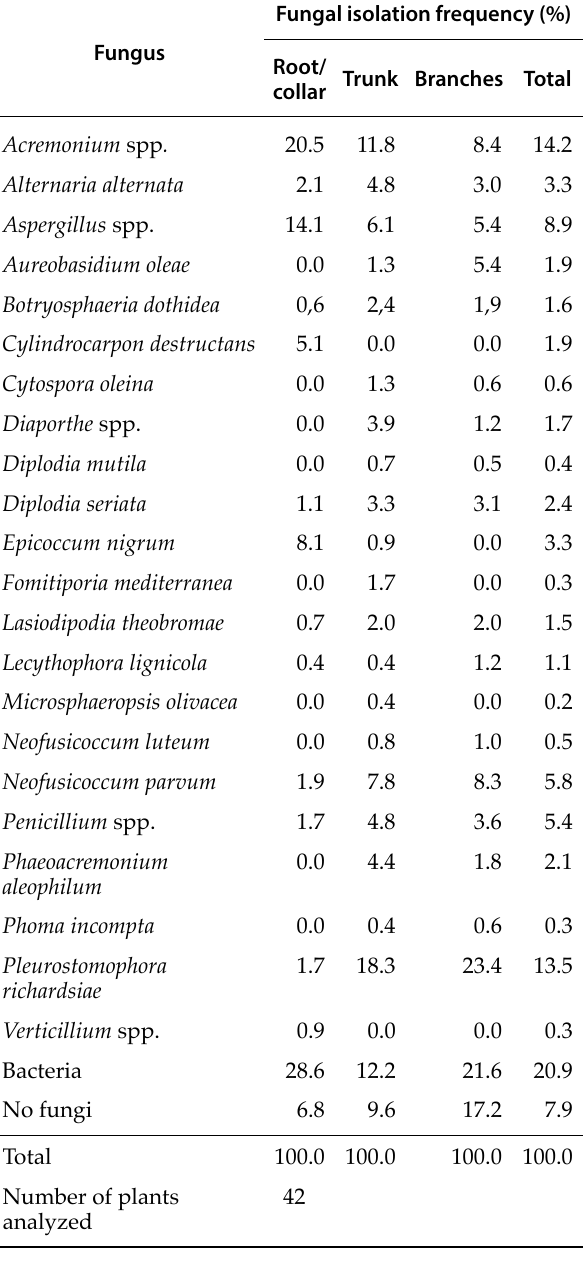
Table 1. Fungi isolated from the cankers and sub-cortical brown streaking of wilted olive